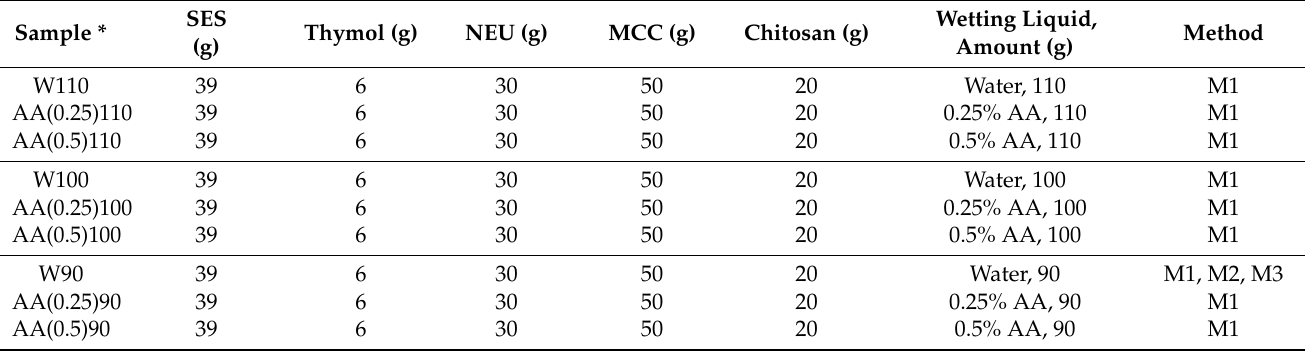
Table 1. Composition of pellet mass for